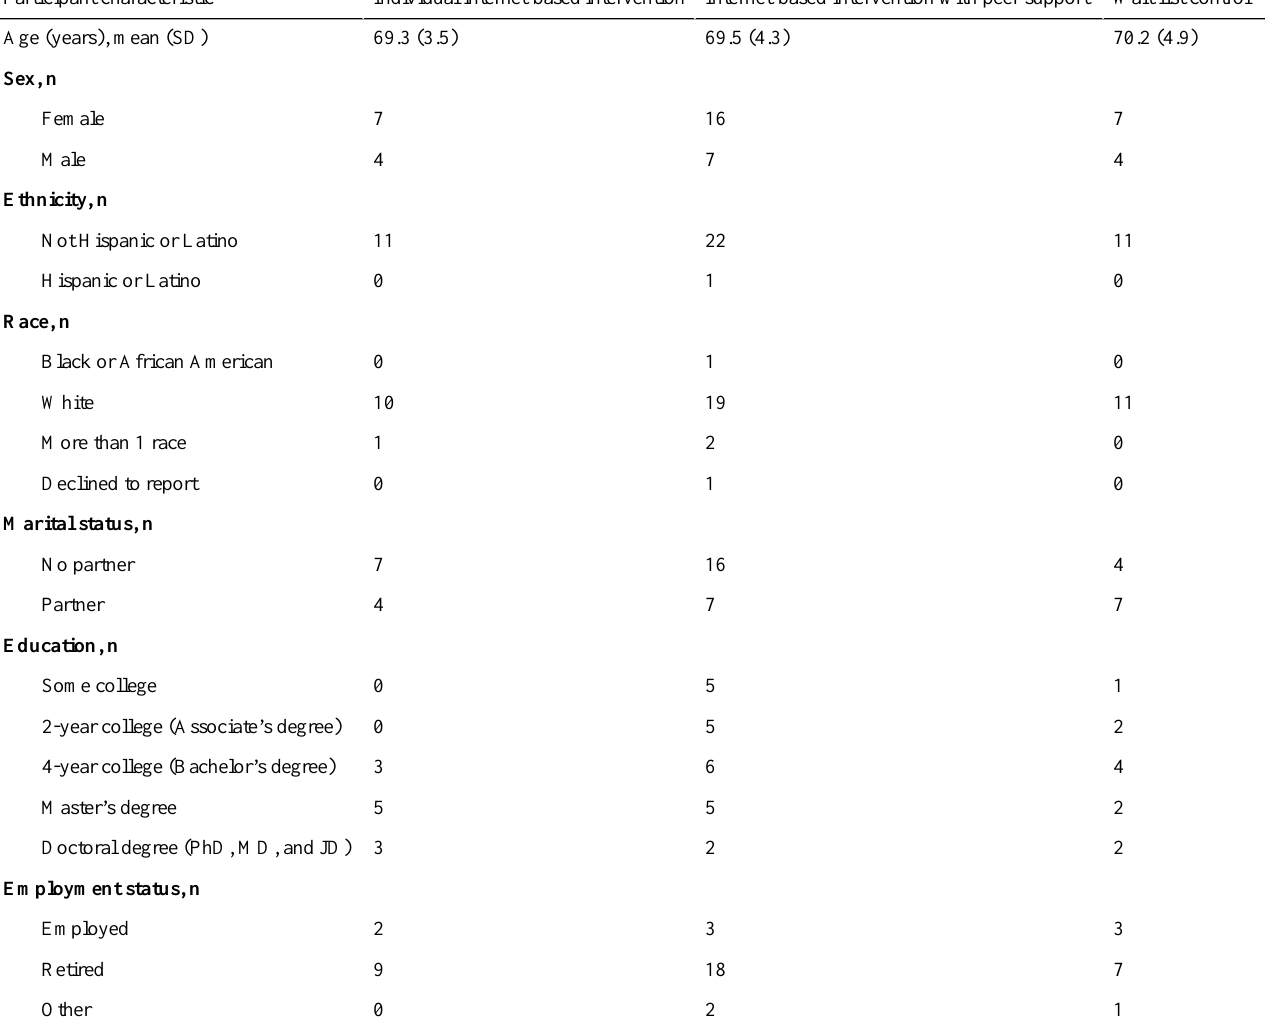
Table 1. Participant